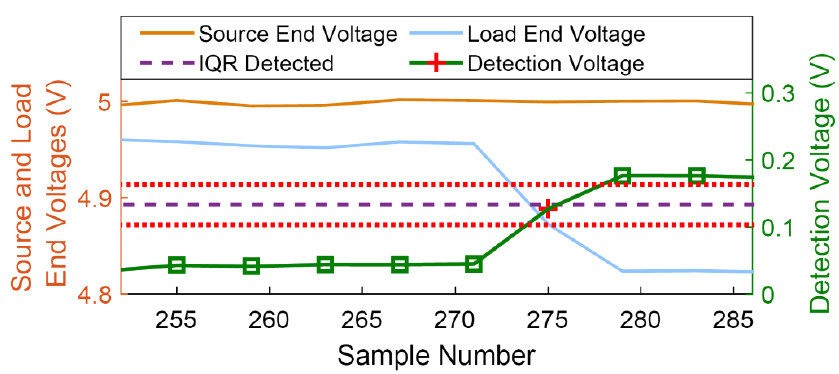
Figure 6. Event 1: detecting a series arc fault using the proposed method. The calculated detection voltage ( V Detect ), which is equal to the differential voltage ( V Dif f ) in this case, is presented by the green line on the right y-axis of Figure 6. As a result of the median filter discussed earlier, there is only one data point for every four samples of voltage data. These data points are shown using green square markers. The dotted red lines show the region around the detected IQR value ( F IQR ) that satisfies the criterion to detect series arc fault, i.e., | V Detect [ k ] − F IQR | < δ . Similar to γ , the δ threshold value was set based on observational analysis. A value of 0.03 V for δ was used and it worked well for all the demonstration cases presented in this paper. A data point in V Detect